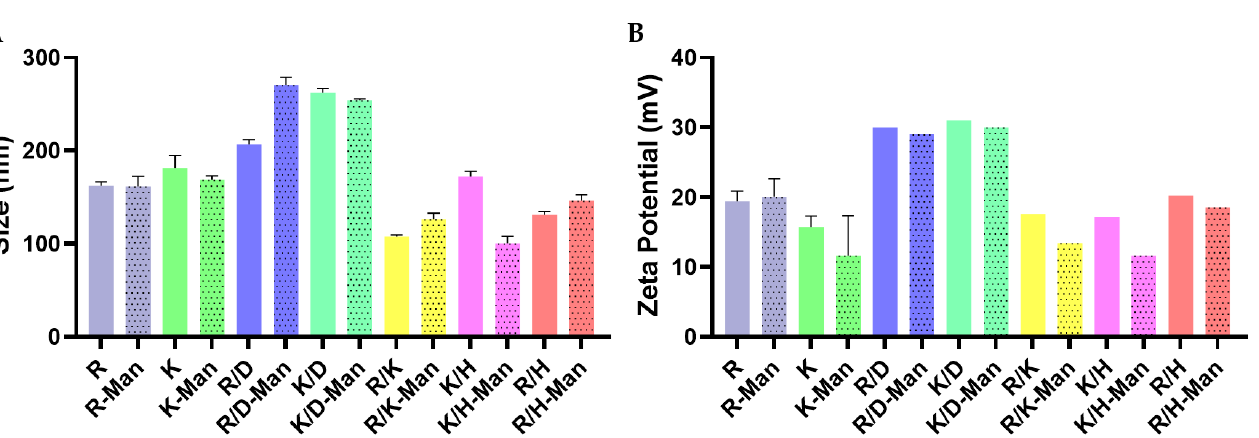
Figure 2. Analysis by Dynamic Light Scattering (DLS) of the average hydrodynamic diameter ( A ) and zeta-potential ( B ) distributions of polyplexes derived from the complexation of pDNA with OM-PBAEs and MM-PBAEs. Polydispersity index (PDI) values were lower than 0.3 for all measurements. Data are shown as mean and SD of triplicates (mean ±